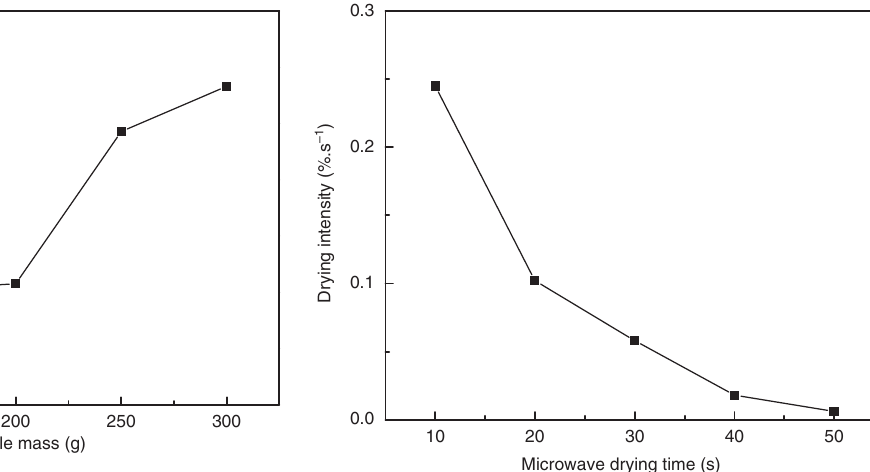
Figure 11: Effects of sample mass on moisture content of high tita- nium slag under microwave drying (microwave power: 700 W; bed depth: 10 mm; drying time: 50 s).